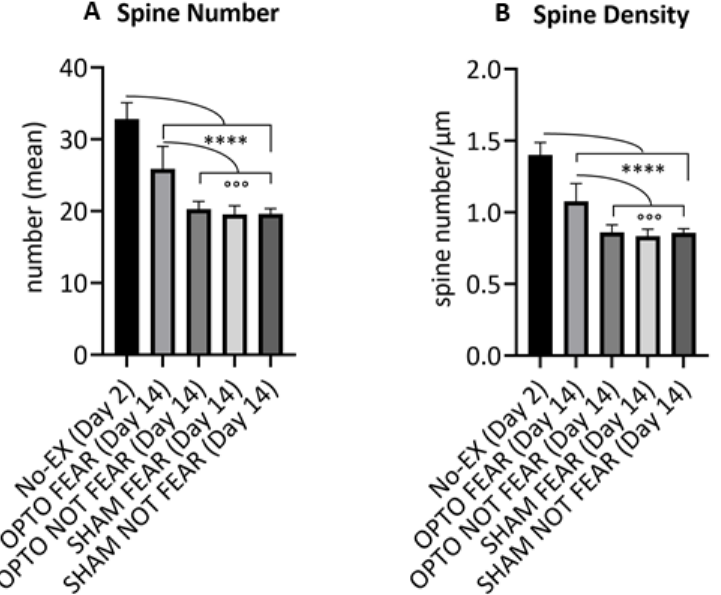
Figure 3. Spine counting of the apical arborizations of Prelimbic pyramidal neurons. No-EX group, encompassing animals submitted to fear learning but not to fear extinction (sacrificed at Day 2), had the highest number ( A ) and density ( B ) of dendritic spines in comparison to OPTO FEAR, OPTO NOT FEAR, SHAM FEAR, and SHAM NOT FEAR groups (**** at least p = 0.0001). The OPTO FEAR group showed higher spine number ( A ) and density ( B ) in comparison to the other groups (°°° at least p = 0.0001) that, in turn, exhibited similar spinogenesis. Data are reported as mean ± SEM.